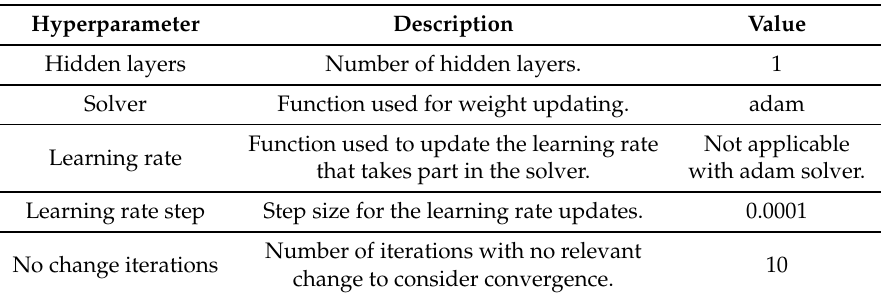
Table 3. Summarization of the fixed MLP